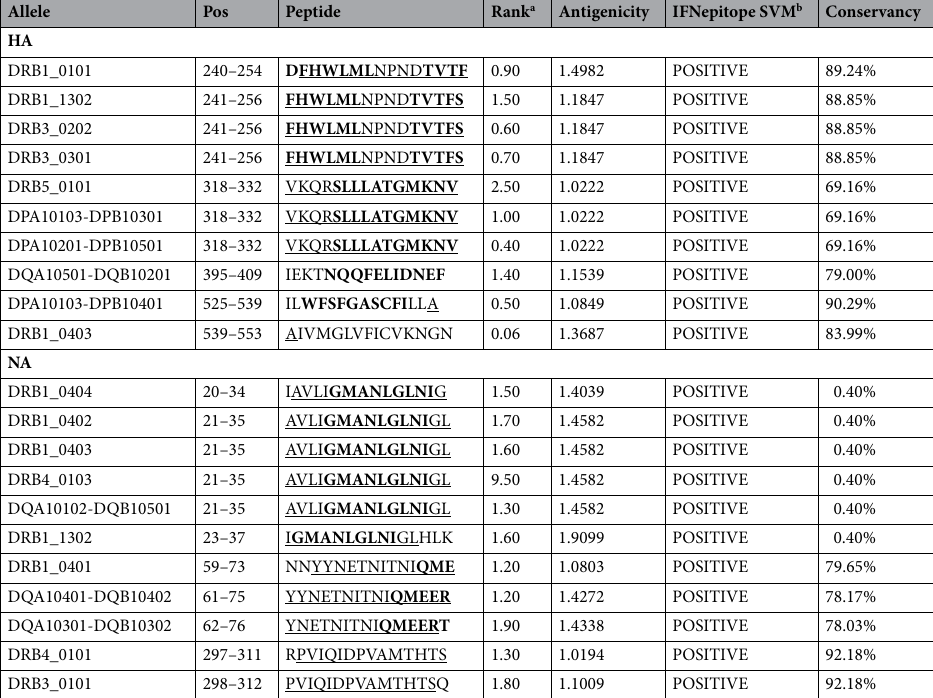
Table 3. HTL epitopes prediction by NetMHCII 2.3 server. HA and NA epitopes were selected based on MHC-II HLAs binding affinity (nM), %rank and antigenicity rate. All epitopes were evaluated based SVM a method as IFN-γ inducer potential and degree of conservation were considered for all selected epitopes. Overlapped HLT epitopes are shown in underlined characters as well as HTL epitopes overlapped with CTL epitopes are shown in bold characters. a Rank Threshold for Strong binding peptides is equal to < 0.5 and for Weak binding peptides is equal to < 2.0. b Motif and SVM hybrid/IFN-gamma versus other